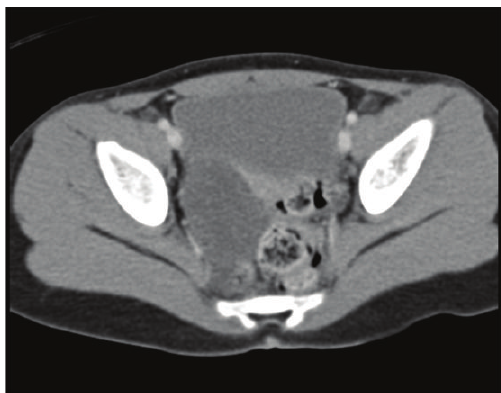
Figure 1: Computed tomography of the pelvis with IV contrast demonstrates a complex loculated fluid collection within right adnexa.